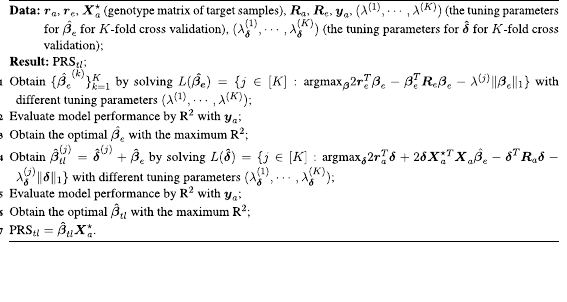
Algorithm 1. Algorithm for TL-Multi.